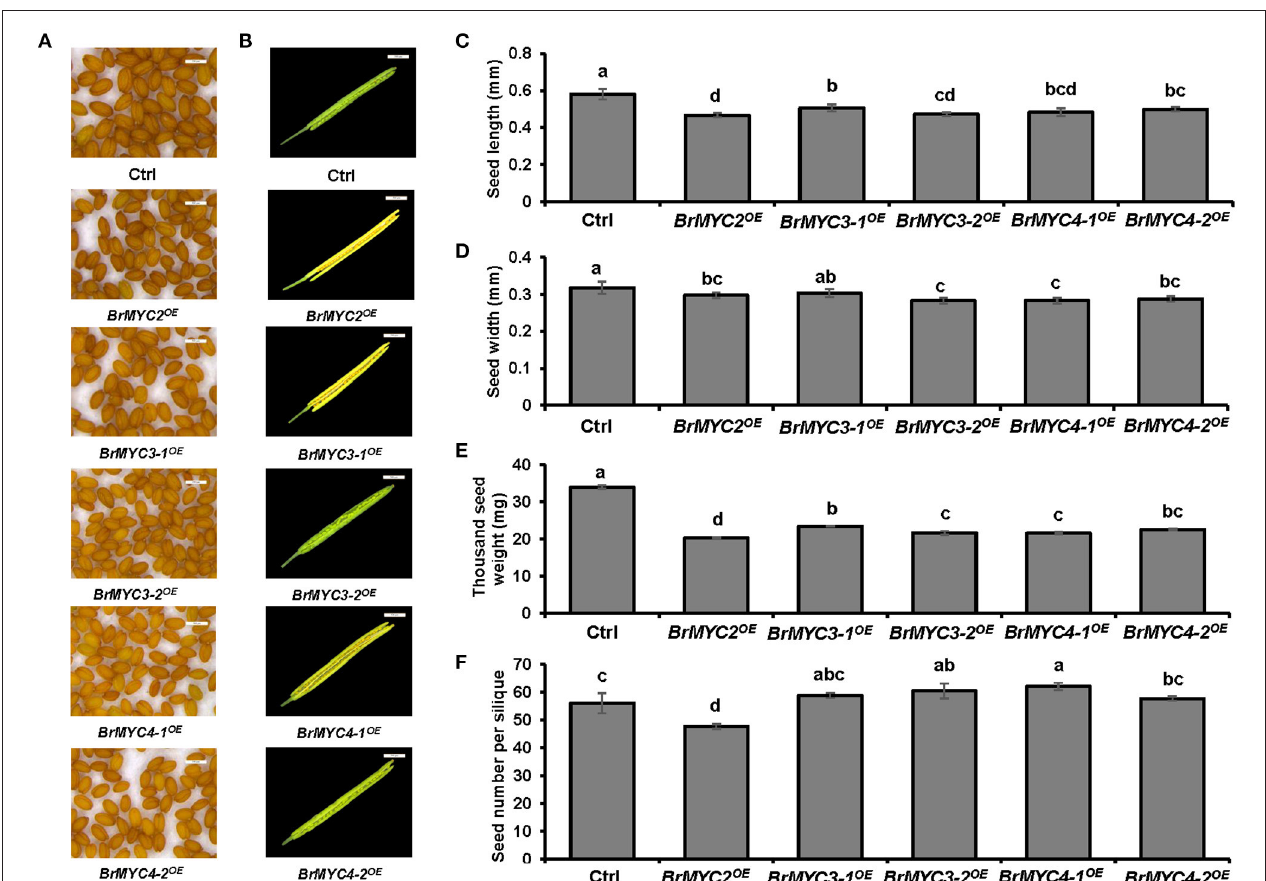
FIGURE 4 | Seed production of T3 Arabidopsis lines transgenic for BrMYC2/3/4 genes. (A) Phenotype of the mature seed. (B) Phenotype of decapsulated mature siliques. (C) Comparison of the seed length. (D) Comparison of the seed width. (E) Comparison of 1,000 seed weight. (F) Comparison of seed number per silique. Tested transgenic lines are Ctrl, BrMYC2 OE , BrMYC3-1 OE , BrMYC3-2 OE , BrMYC4-1 OE , and BrMYC4-2 OE . Seeds and siliques were randomly selected and pictures were taken under the same conditions. Data are shown as mean ± SD from three independent biological replicates. ANOVA was used for statistical analysis, followed by Tukey’s multiple comparison test ( p < 0.05). Bar = 500 µ